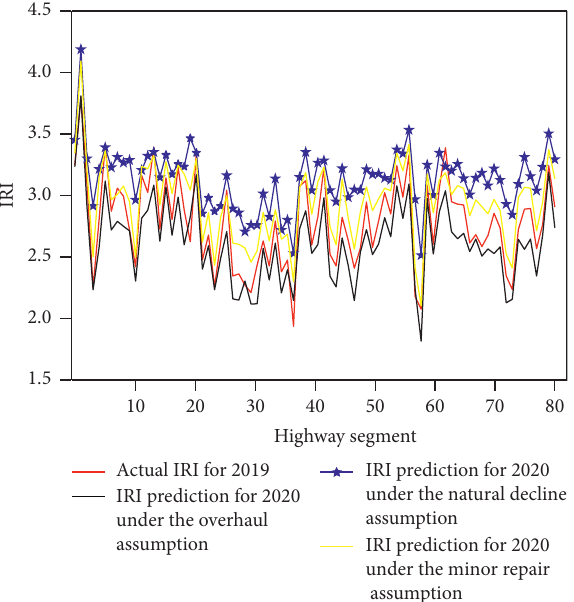
Figure 13: Variation prediction trend of the pavement performance of the Dalian highway in